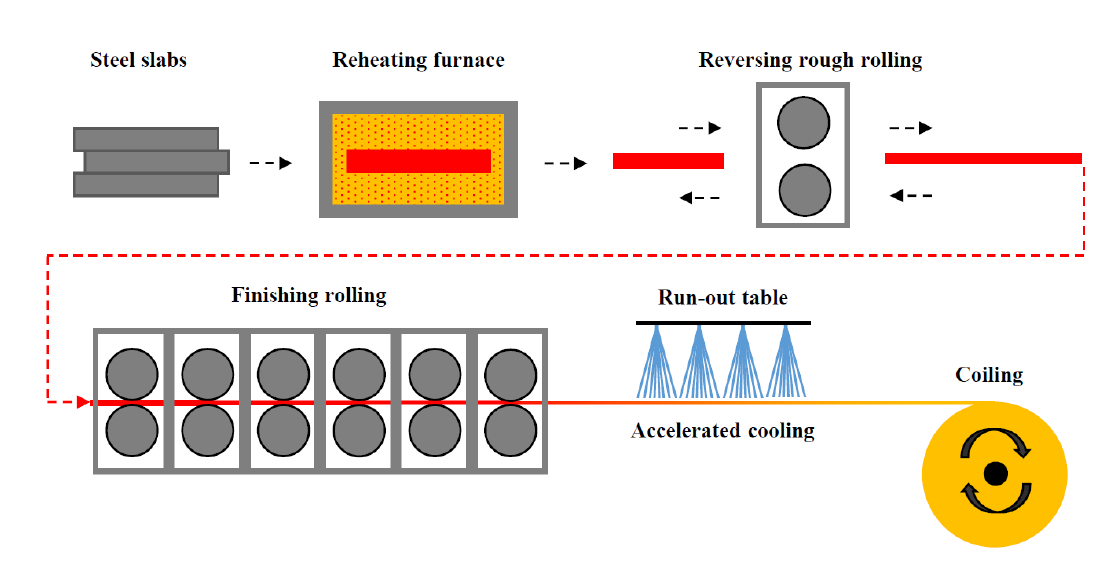
Figure 1. Schematic representation of the elaboration process of a bainitic steel sheet.